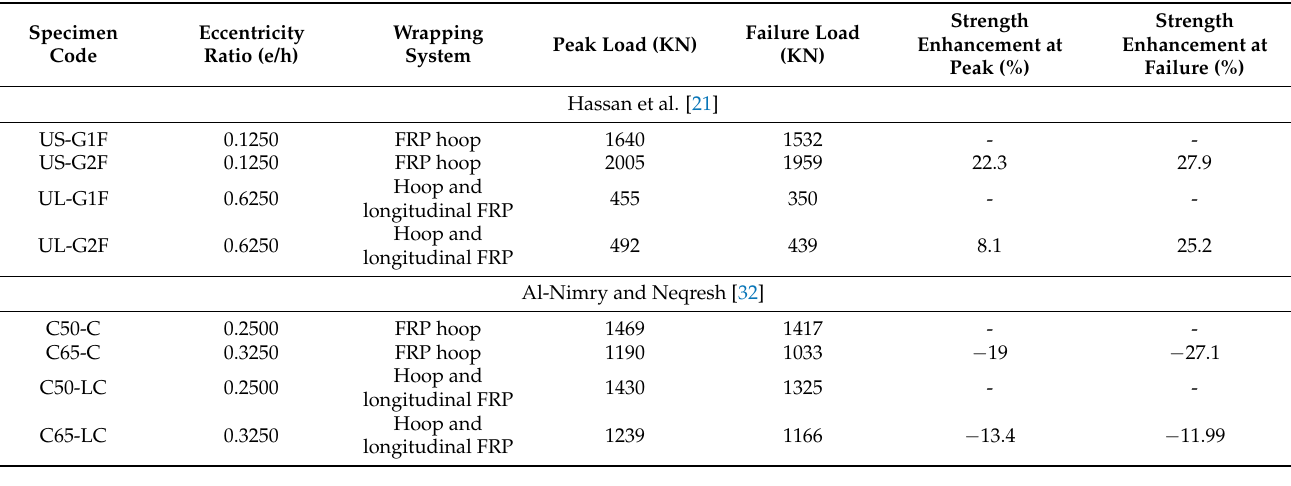
Figure 18. Comparison between experimental and predicted ultimate load ratios for FRP-confined RC columns. Table 9. Comparison between experimental results of selected RC columns with FRP wraps or a combination of FRP hoop and longitudinal